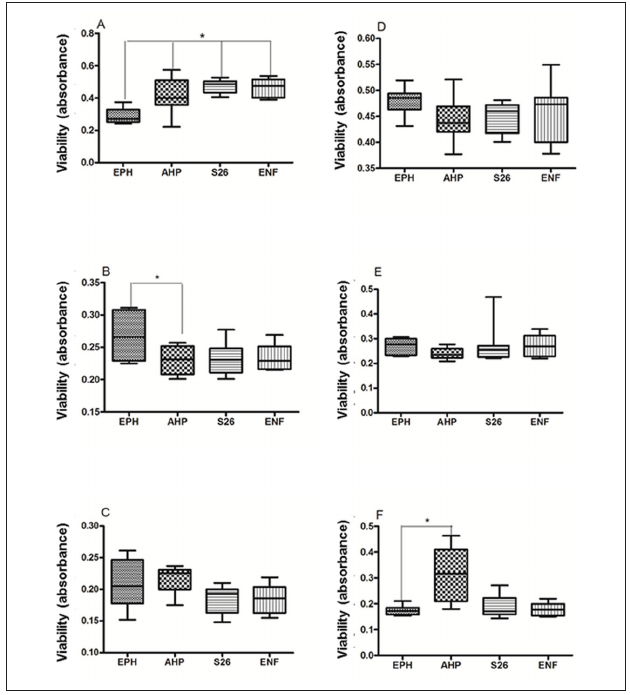
Fig. 1: Cell viability of fibroblasts (A, B, C) and macrophages (D, E, F) cultivated with Epiphany (EPH), AH Plus (AHP), Sealer 26 (S26) and Endofill (ENF) at different periods of time. *Statistically significant differences between